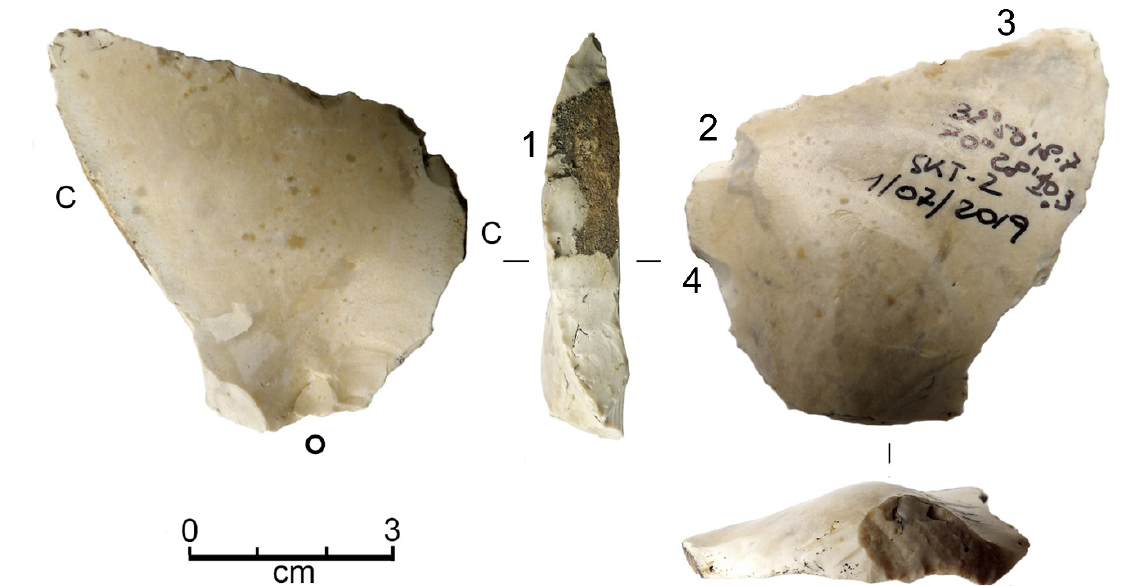
Figure 5. Déjeté Levallois tool recovered from the surface of a black varnished pebble terrace at point N32°50’18.7” - E70°28’10.3”, ca. 500 m south-west of Sheri Khan Tarakai with the indication of the points where part of the original dark grey cortex covering the flint pebble is still preserved (C), the points where the microphotographs of Figure 6 were taken (nn. 1-4), and the location of the platform (small circle) (photographs by E. Starnini,